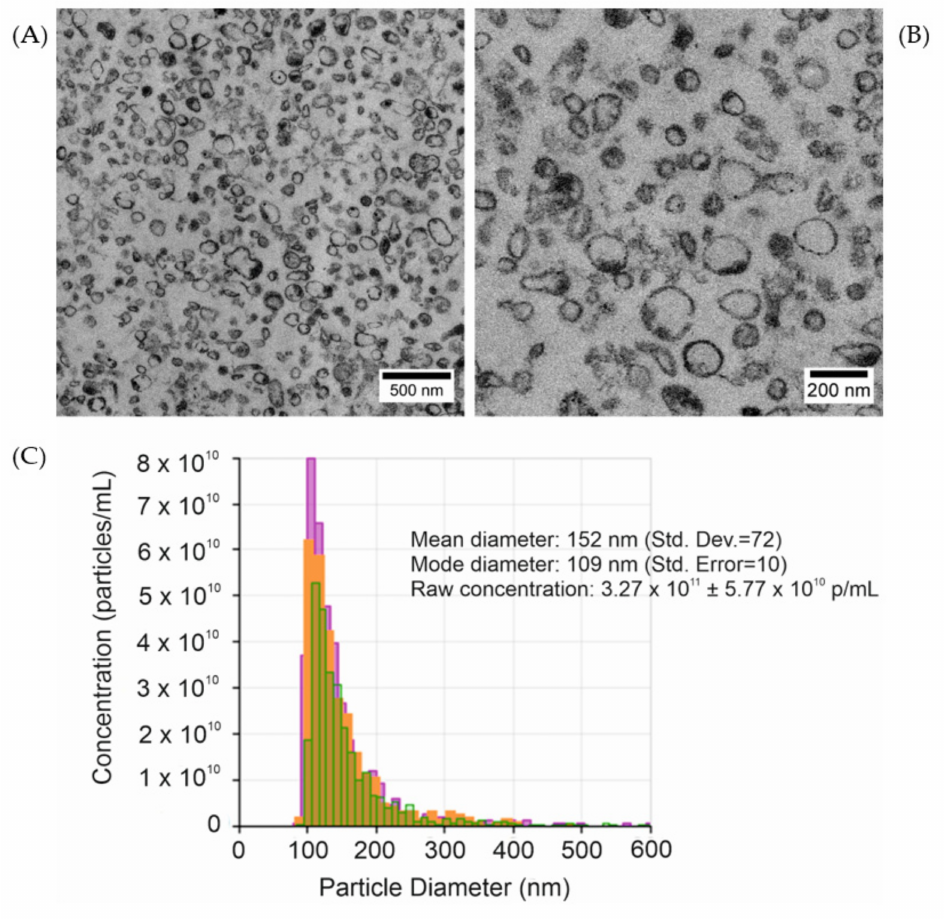
Figure 1. ( A , B ) Transmission electron micrographs of isolated uEVs at two different magnifications; and ( C ) the size distribution of uEVs obtained by qNano